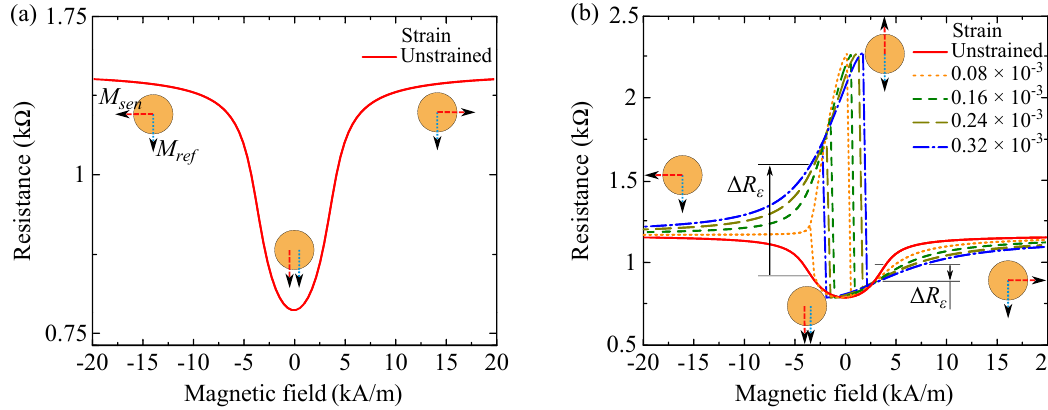
Figure 3. ( a ) Calculated R ( H ) loop in the unstrained state as the magnetic field is perpendicular to the induced anisotropy ( H ⊥ K u ); ( b ) Changes in the R ( H ) loop imposed by different levels of tensile strain. Applying tensile strain leads to changes in the resistance ( ∆ R ε ) at different magnetic